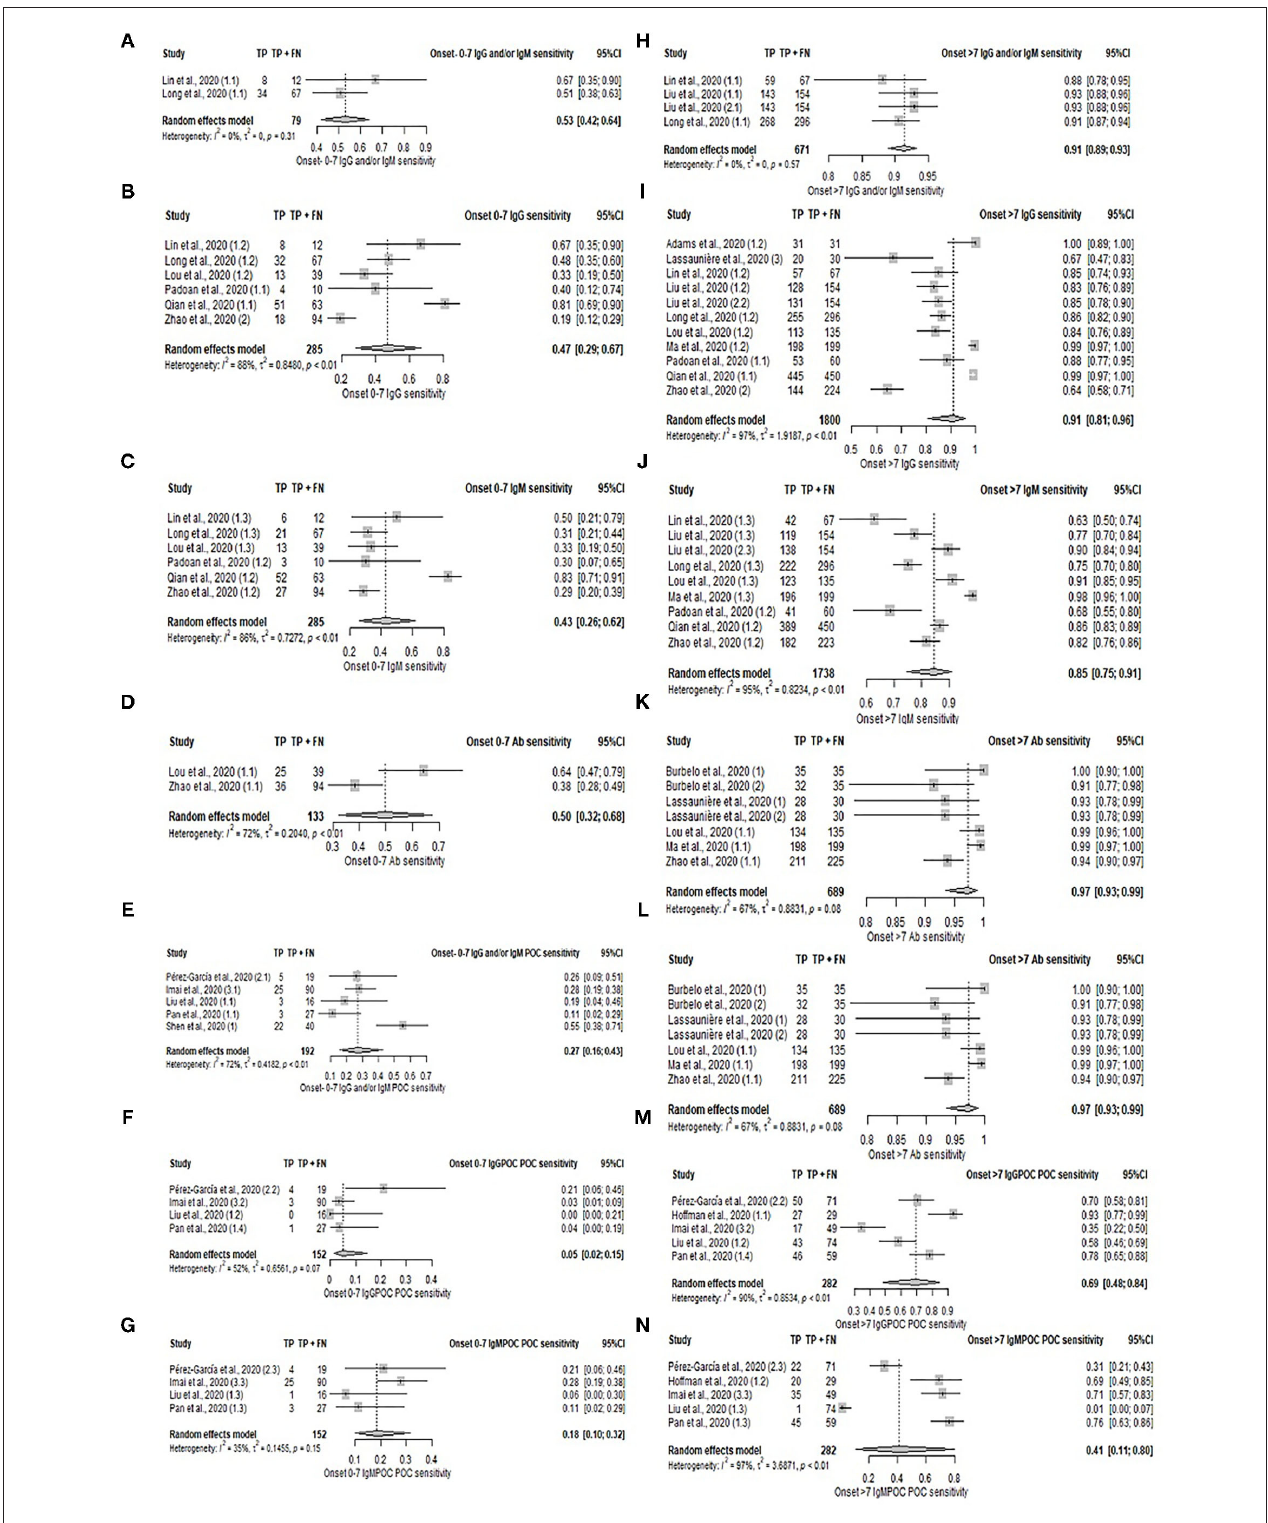
FIGURE 3 | Forest plot on sensitivity of serology test in early and late phases of disease. (A–G) Pooled sensitivity for early phase: (A) IgG and/or IgM, (B) IgG, (C) IgM, (D) Ab, (E) IgG and/or IgM (POC), (F) IgG, and (G) IgM. (H–N) Pooled sensitivity for late phase: (H) IgG and/or IgM, (I) IgG, (J) IgM, (K) Ab, (L) IgG and/or IgM (POC), (M) IgG, and (N)